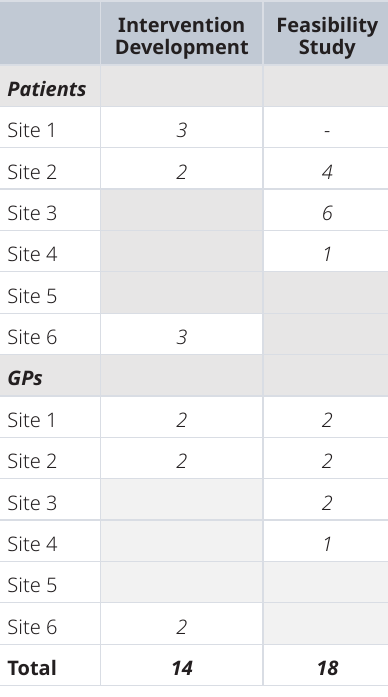
Table 6. Patient and practice interviewees for the summary report. Intervention Feasibility Development